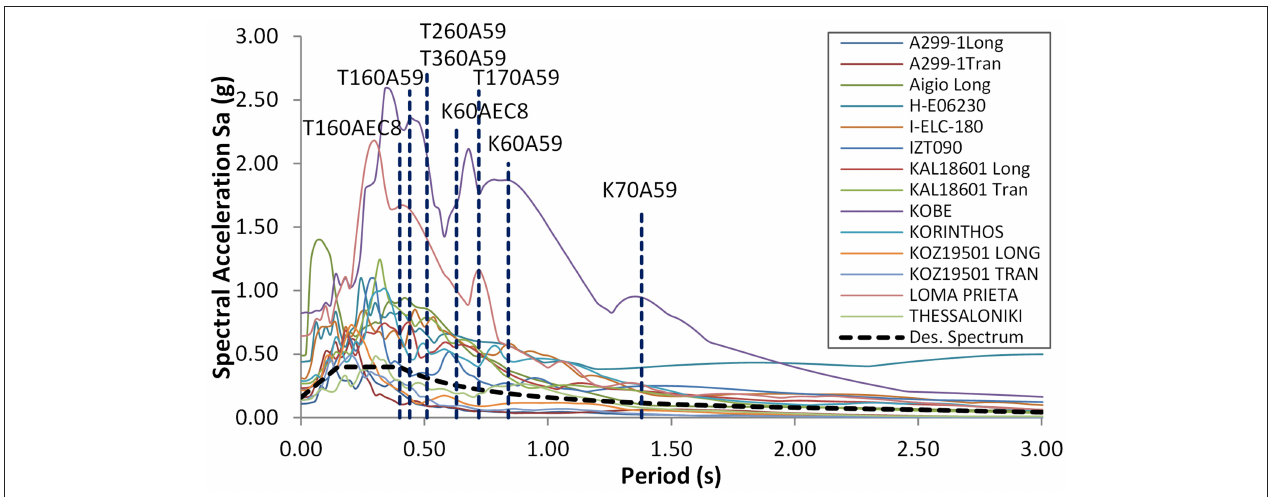
FIGURE 6 | Elastic response spectra of the as recorded accelerograms and predominant periods of the case study